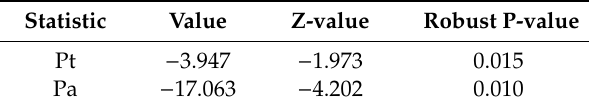
Table A11. Panel cointegration